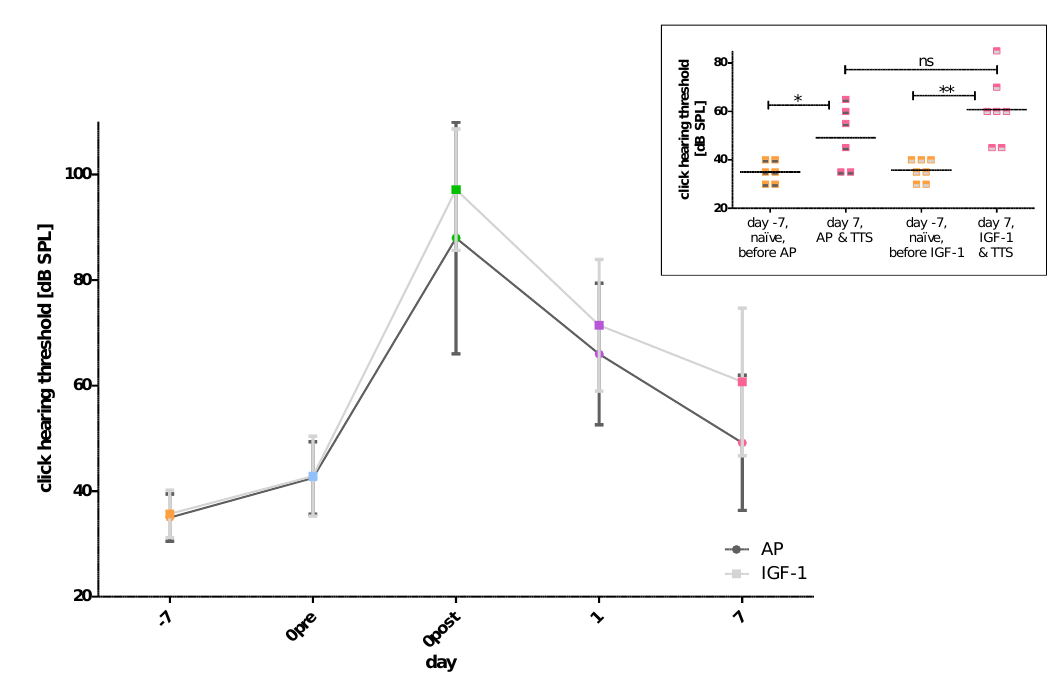
Figure 2. The click hearing thresholds of the implanted ears are illustrated. ( A ) The mean hearing thresholds of the two treatment groups (AP (dark grey) and IGF-1 (light grey)) are displayed over time (day − 7 orange, day 0 pre noise blue, day 0 post noise green, day 1 violet, day 7 pink). ( B ) The individual thresholds and the means of both treatment groups, when included into the study (day − 7, naïve, orange) and 7 days after TTS (pink) are illustrated. In both groups a significant threshold increase is observed with a larger before-after difference in the IGF implanted ears than in the AP implanted ears. One week after TTS the hearing threshold of the two groups did not differ significantly. ns = not significant; * p ≤ 0.05; ** p ≤ 0.01.